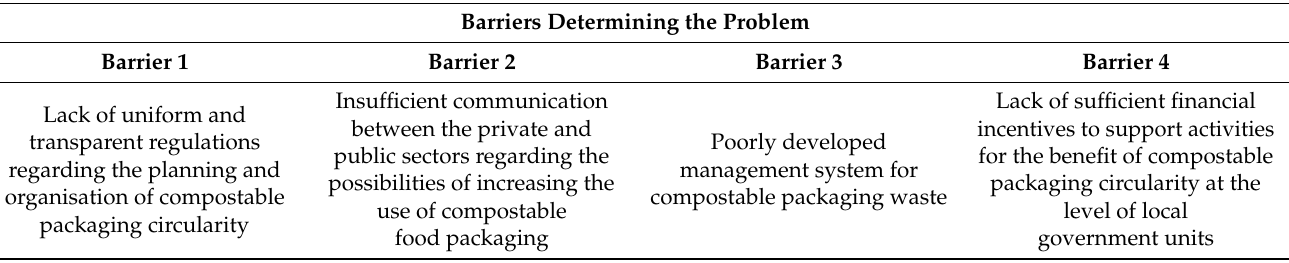
Table 1. Barriers determining the problem of the low level of development of compostable packaging waste